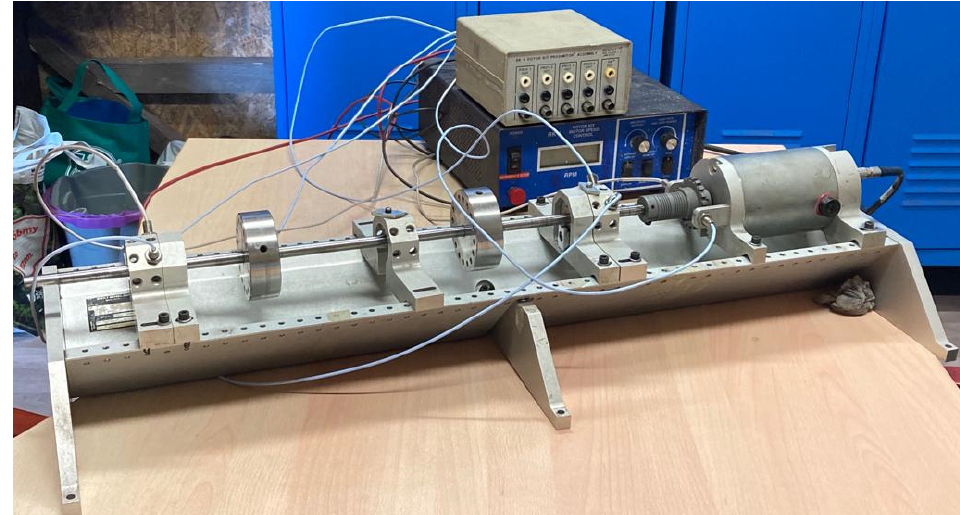
Figure 6. Picture of the Rotor Kit test rig used for model validation.